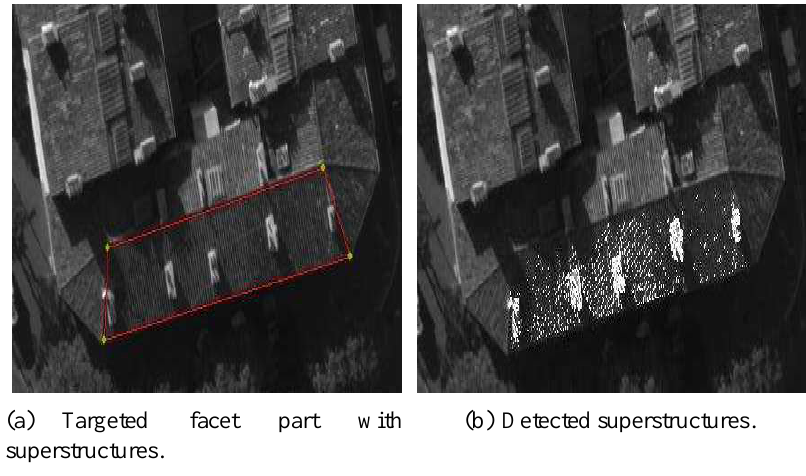
Figure 20. Automatic detection and filtering of the superstructures. The threshold T proportional to the median of all residuals. The removed pixels are shown in white.